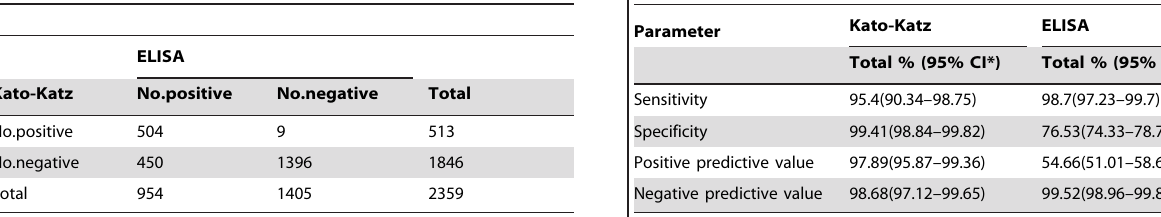
Table 2. Comparison of the Kato-Katz methods and ELISA for diagnosis Clonorchis sinensis infection in Heilongjiang Province.